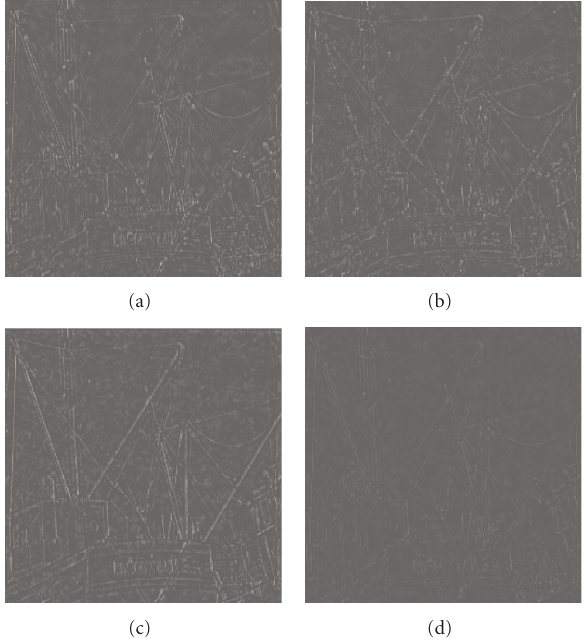
Figure 9: The di ff erence images between the original “Boat” and restored “Boat” images in Figure 8: (a) by the curvelet Shrinkage method; (b) by using the “TV” model; (c) by using the “TVGF” model; (d) by using our proposed